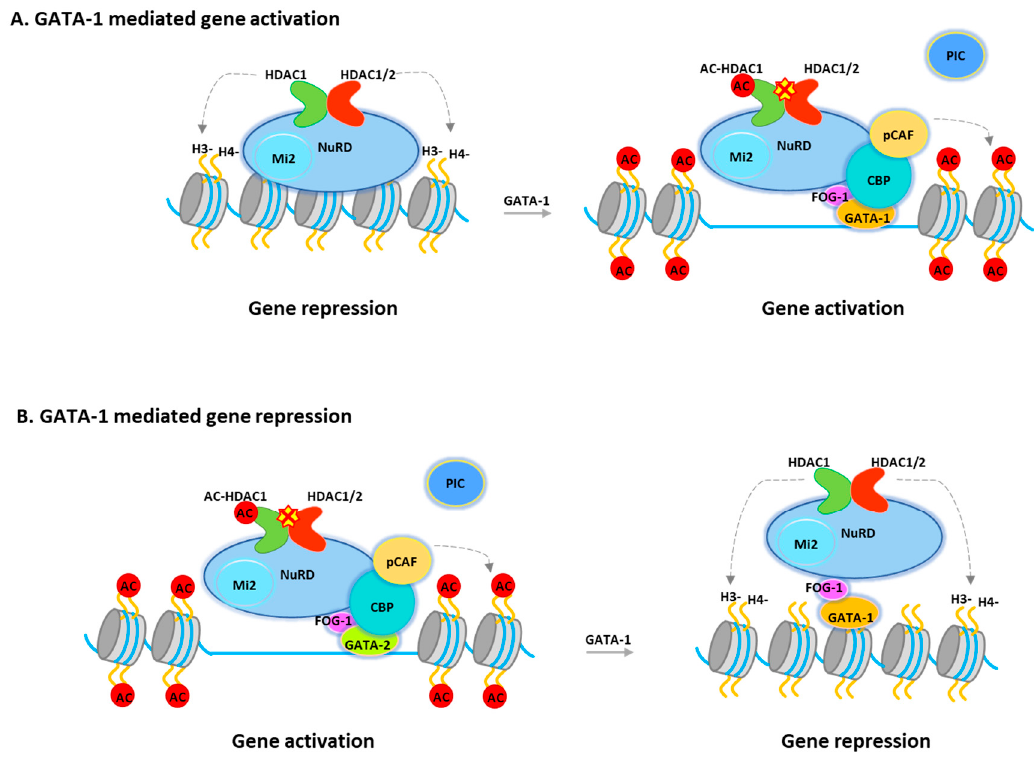
Figure 2. HDAC1 in NuRD complex mediates GATA-1 function. ( A ) A model for GATA-1